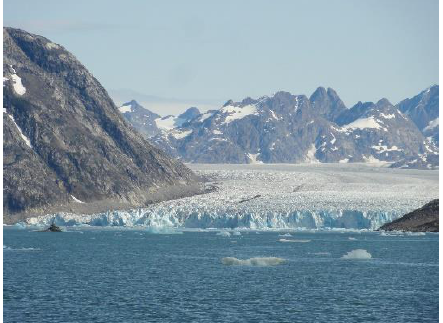
Figure 4. Knud Rasmussen Glacier; it appears to be a small glacier, but its width is over 2 km. 4. Used Instruments